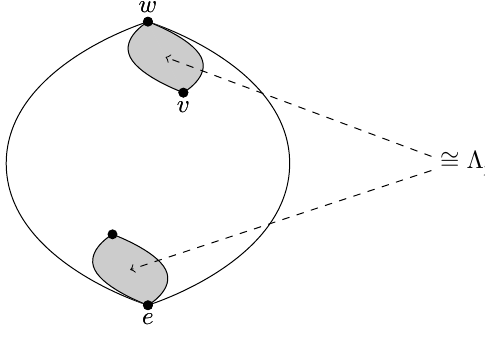
Fig. 3: When a permutation w contains a vexillary pattern p , then Λ w will contain intervals isomorphic to Λ p as indicated by the shading. (There may, of course, be other intervals in Λ w isomorphic to Λ p as well.) Example 1.8 The permutation 4213 contains the vexillary pattern 321 . The interval [1243 , 4213] and the principal order ideal Λ 3214 are both isomorphic to Λ 321 , as shown in Figure